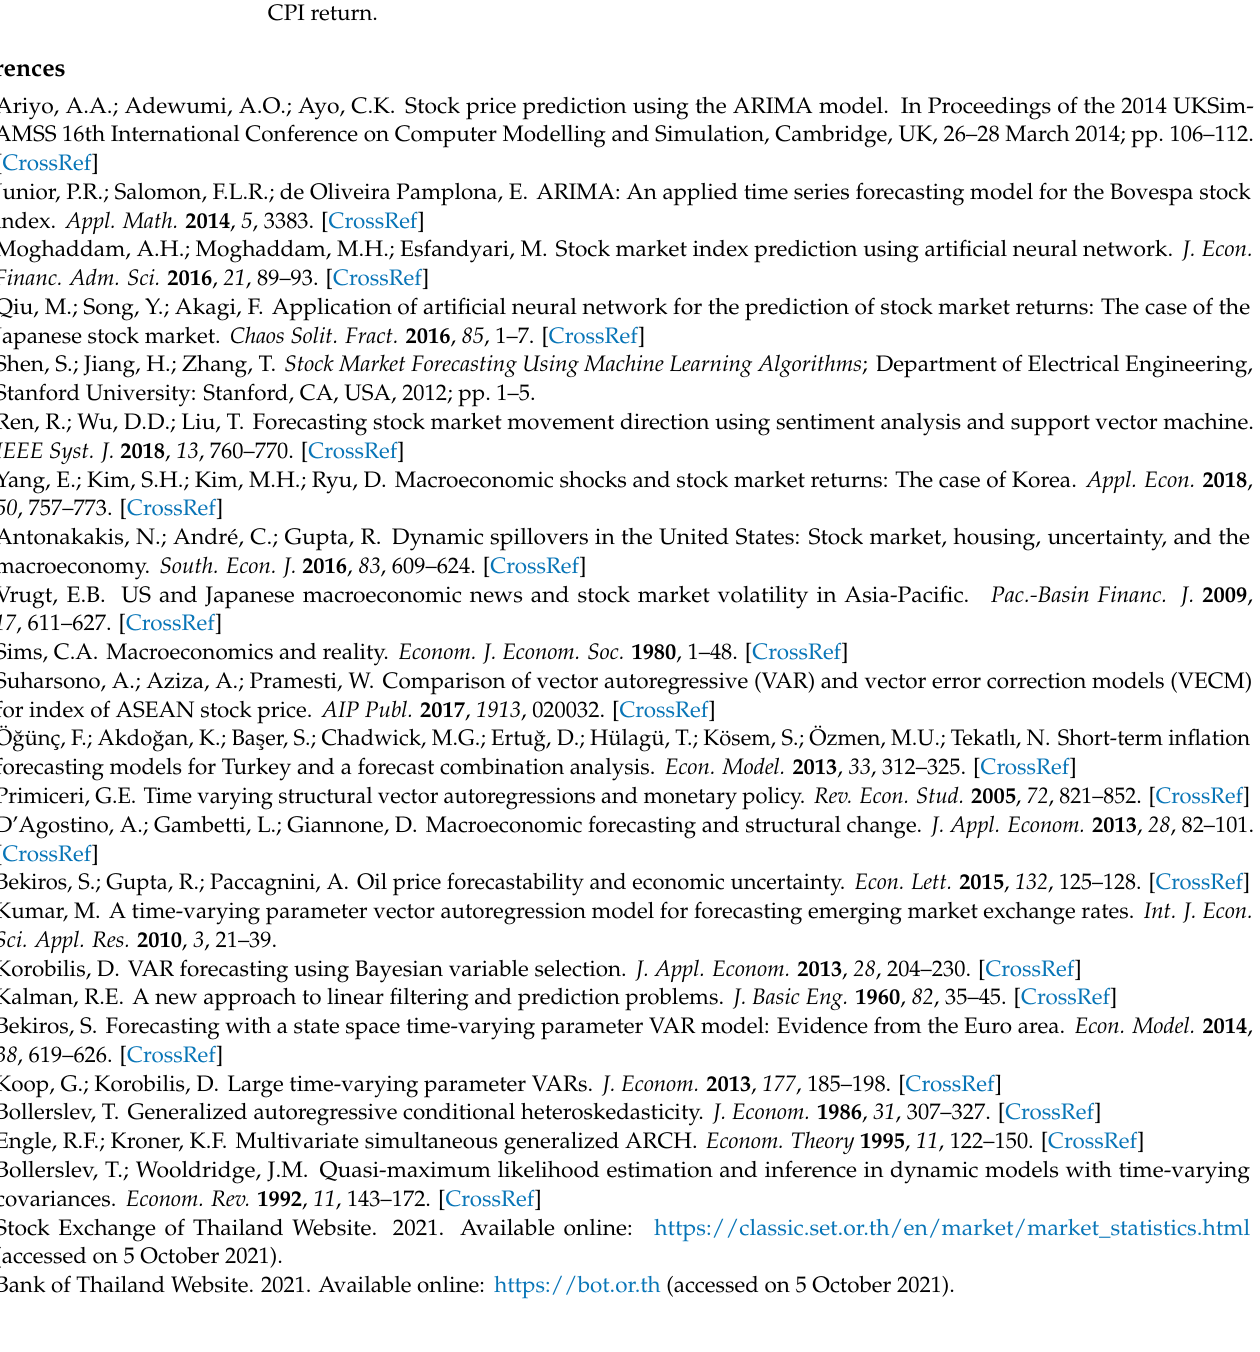
Figure A2. Plots of the actual data and the estimated values from three methods for Indonesia. ( a ) Normalized SET index return; ( b ) normalized real effective exchange rate return; ( c ) normalized CPI